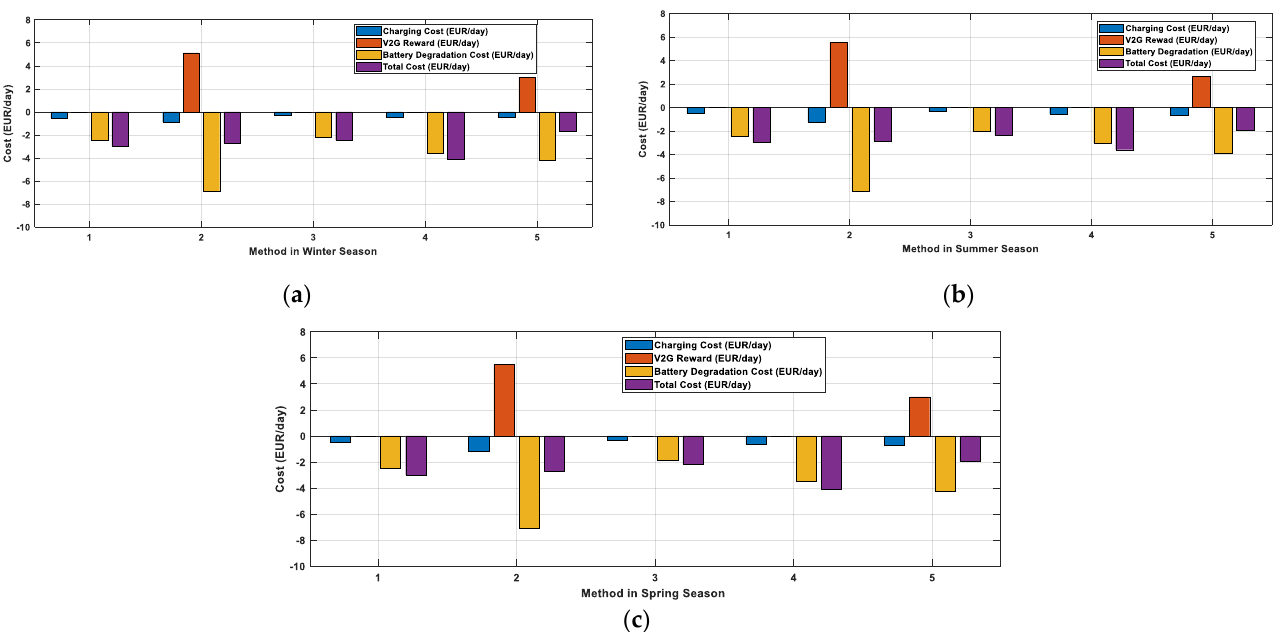
Figure 18. Total cost for ( a ) winter, ( b ) summer, and ( c ) spring (1 = uncoordinated charging; 2 = Method 1; 3 = Method 2; 4 = Method 3; 5 = proposed method).